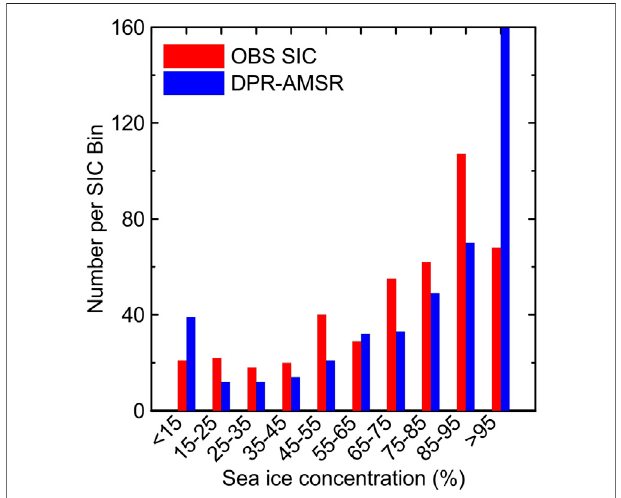
FIGURE 9 | Histogram of co-located daily average sea ice concentrationfrom ship-based visual observations (OBS) (red) and from DPR- AMSR (blue). Data were from 2002 to 2011. sea ice concentrations were separated into the following bins: < 15%, 15% – 25%, 25% – 35%,